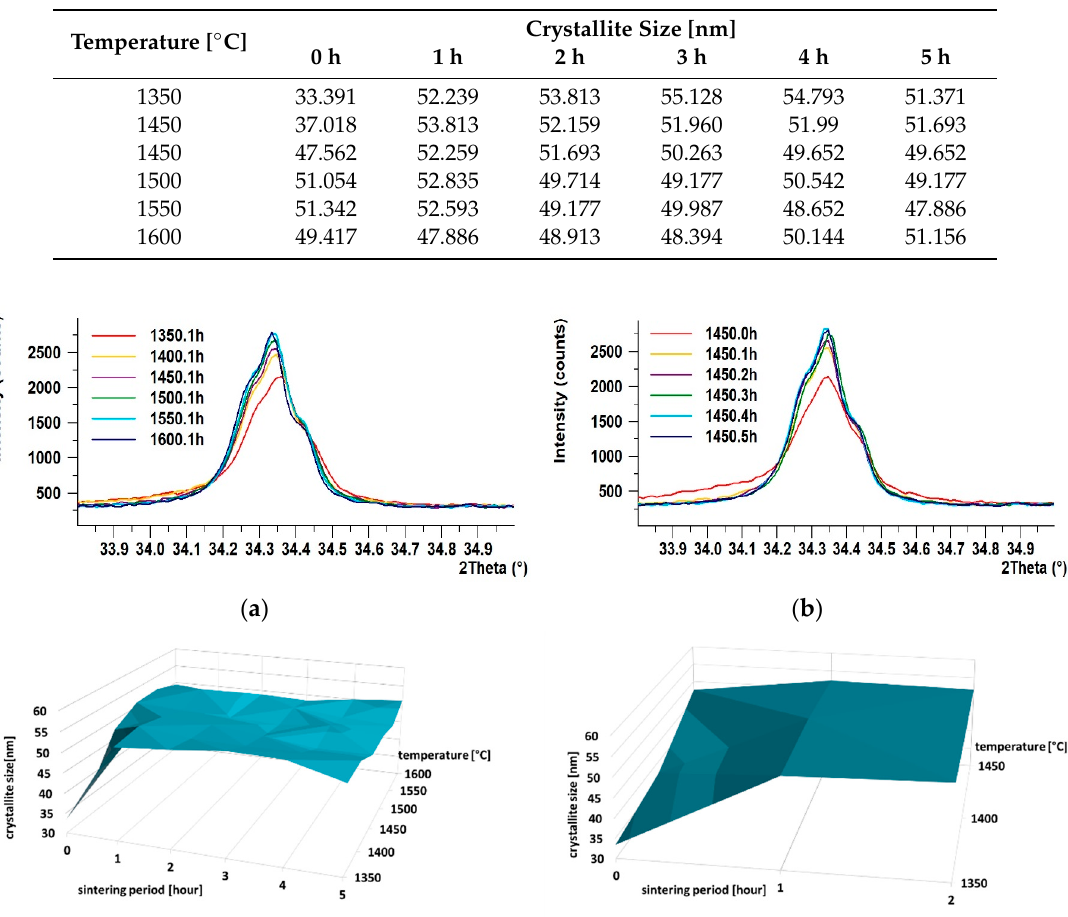
Figure 5. Development of crystallinity. ( a ) Influence of temperature on crystallite size at 1 h of sintering; ( b ) influence of sintering period on crystallite size at 1450 ◦ C; ( c ) 3D graph of growth of crystallites in plane 445; ( d ) detail of 3D graph of growth of crystallites in plane 445. Table 4. Growth rate of crystallite size.